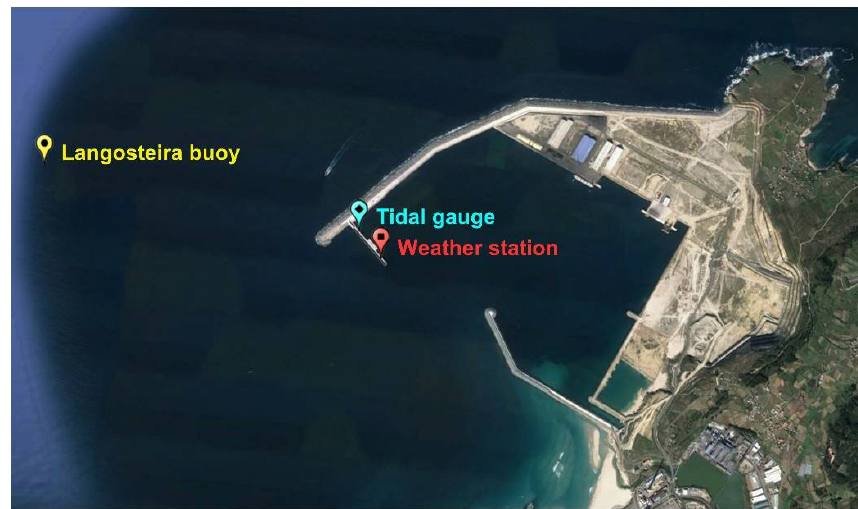
Figure 1. Location of different measuring devices/sources of the met-ocean variables in the available database. Outer Port of Punta Langosteira (A Coruña). Source: elaborated from Google Earth.